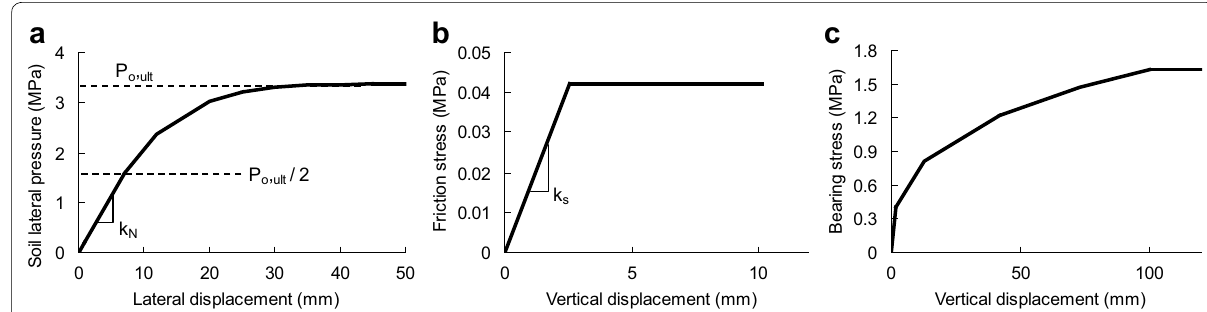
Fig. 6 Constitutive models of soil: a lateral response; b shaft friction response; c end bearing response.